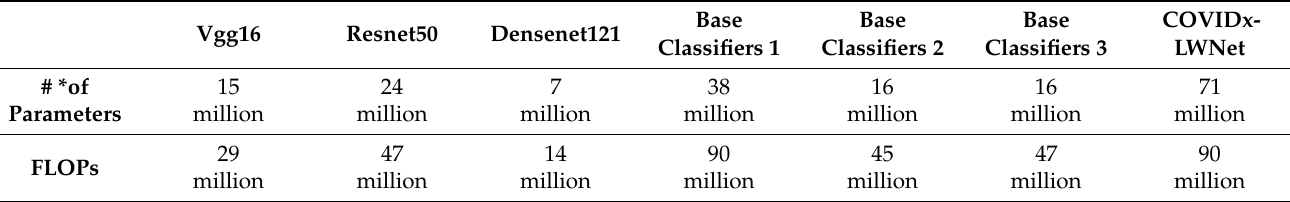
Table 8. the parameters and FlOPs of the